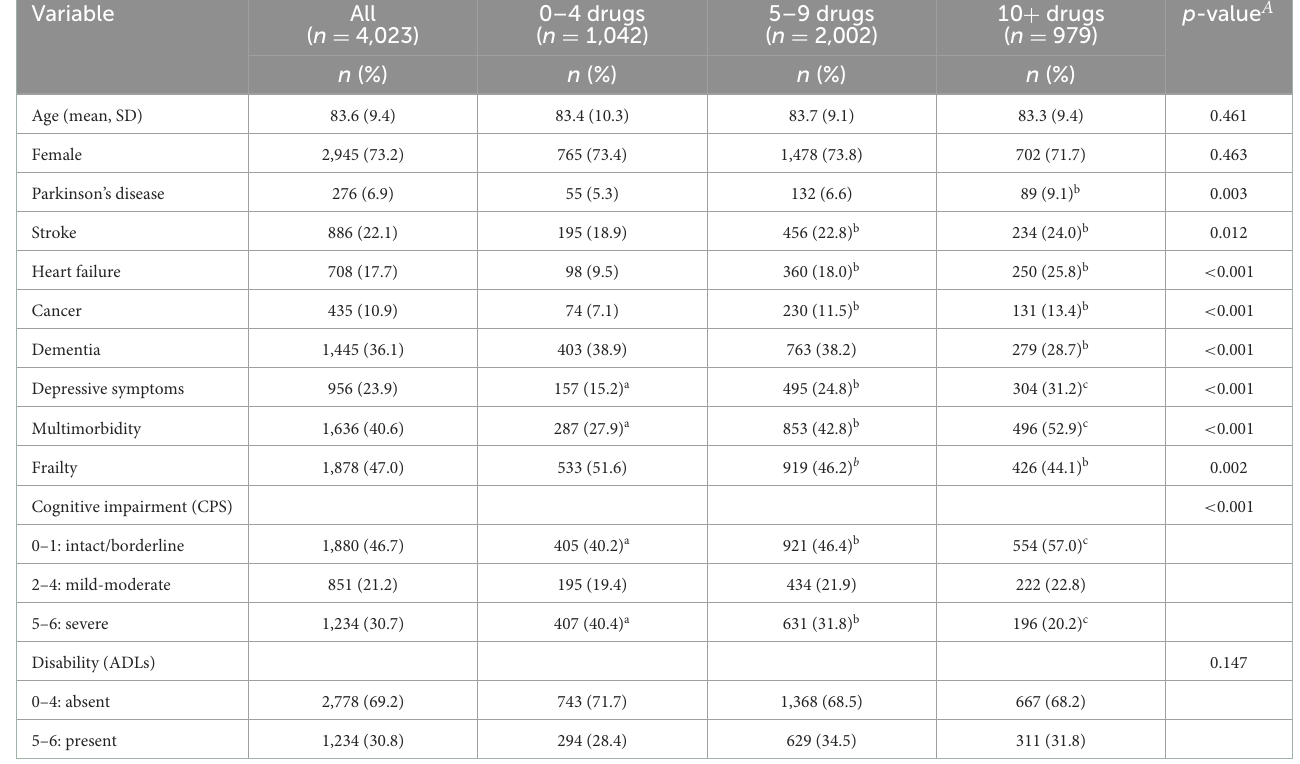
TABLE 1 Baseline characteristics of the study population.